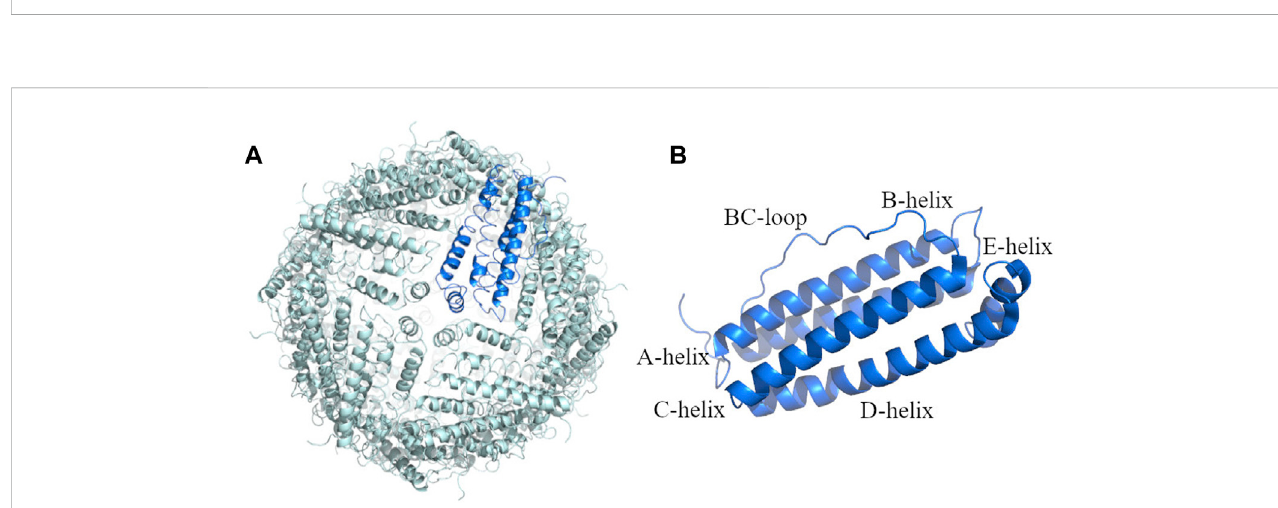
FIGURE 4 X-ray structure of the hHFt reassembled after disassembly in SDS: (A) the 24-mer (hHFt SDS ); (B) the single chain of hHFt. The asymmetric unit of the crystal contains one single chain; the 24-mer is generated by crystal symmetry. In panel B, the four helices (A-D), the short helix at the C-terminal tail (helix E) and the BC loop are highlighted. The structure has been deposited with the PDB code